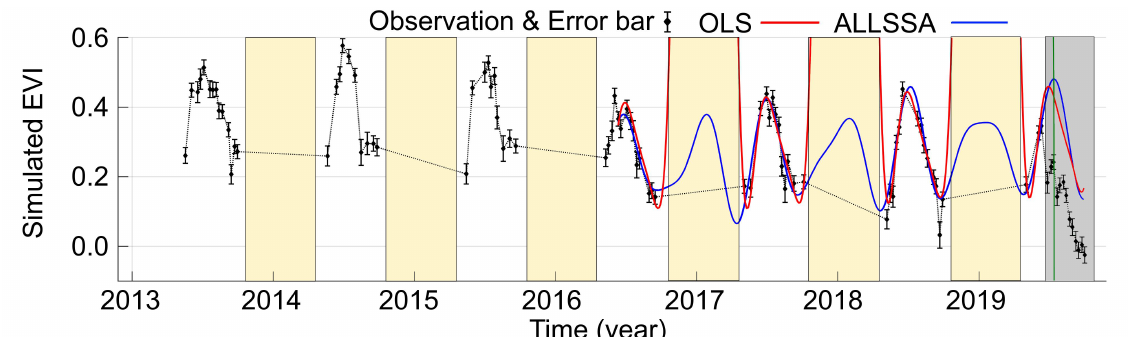
Figure 4. A simulated unequally spaced time series with consistent data gaps (yellow backgrounds) and error bars. The estimated components in SHP (mid-2016 to mid-2019) by the OLS and ALLSSA season-trend models are shown with red and blue solid lines, respectively. MP (gray background) started right before an abrupt change with magnitude − 0.2 occurs. After three new incoming observations, the abrupt change is detected at the time location shown by green vertical